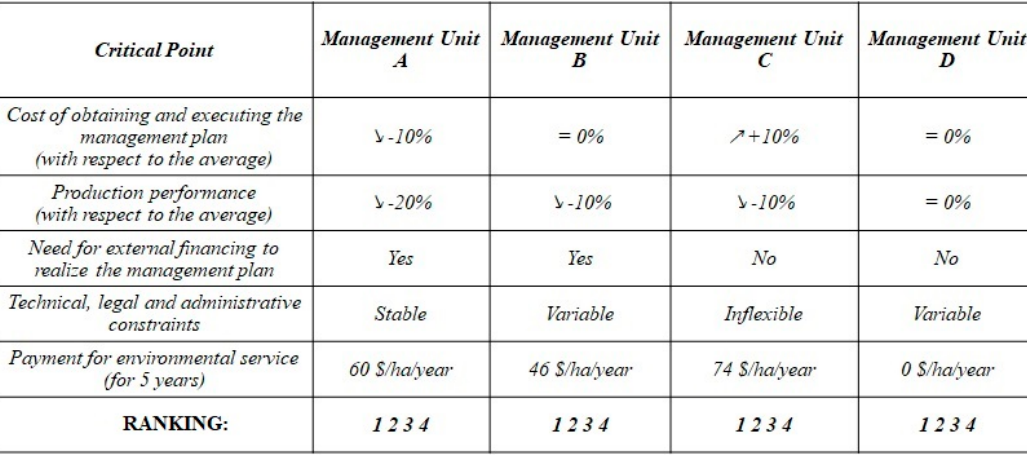
Figure 4. Example of one of the choice cards used in round II of the Delphi method. Each expert selected the order for the MUs A to D, where 1 represents the most sustainable MU and 4 the least sustainable.